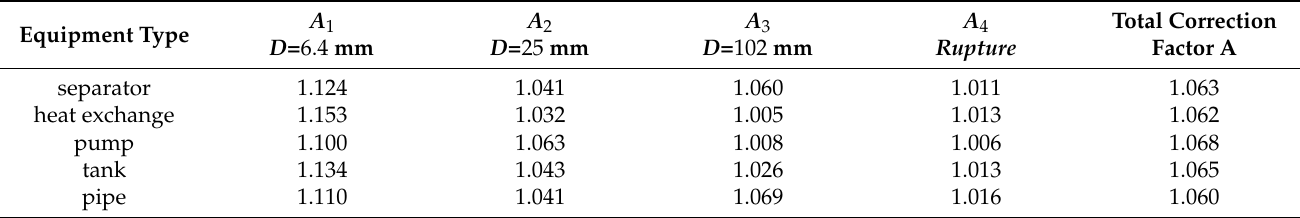
Table 15. Correction factor of calculation formula in equipment damage